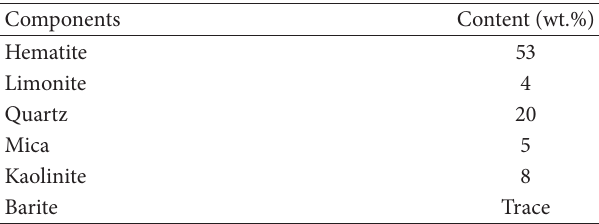
Table 1: Mineral composition of the hematite ore.